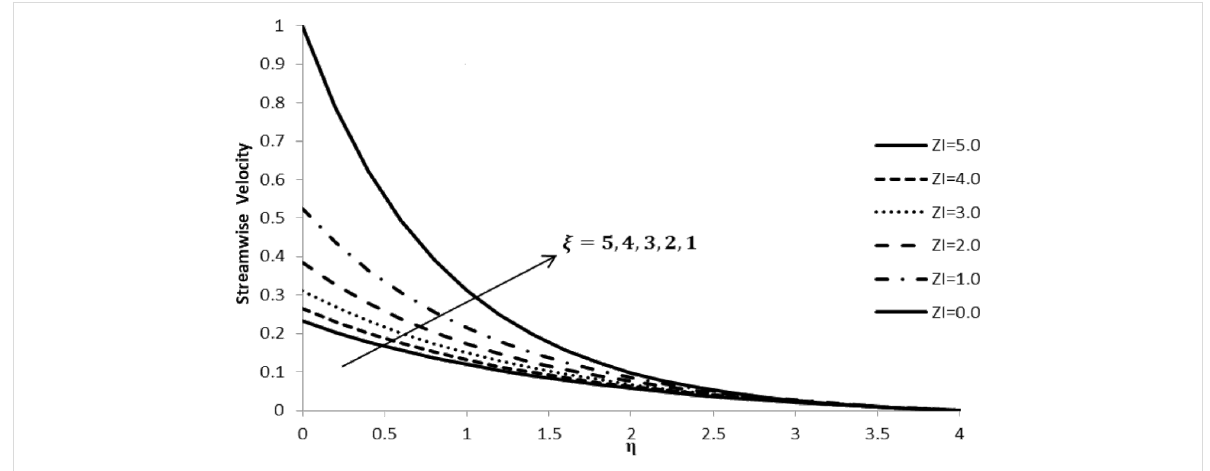
Figure 2: Influence of the slip parameter for liquids ξ on the streamwise velocity component f ´( η ) when n = 2.0, M = 0.0, Q = 0.0, Pr = 2.0, Nb = Nt = 0.5, Le = 5.0, and F w =